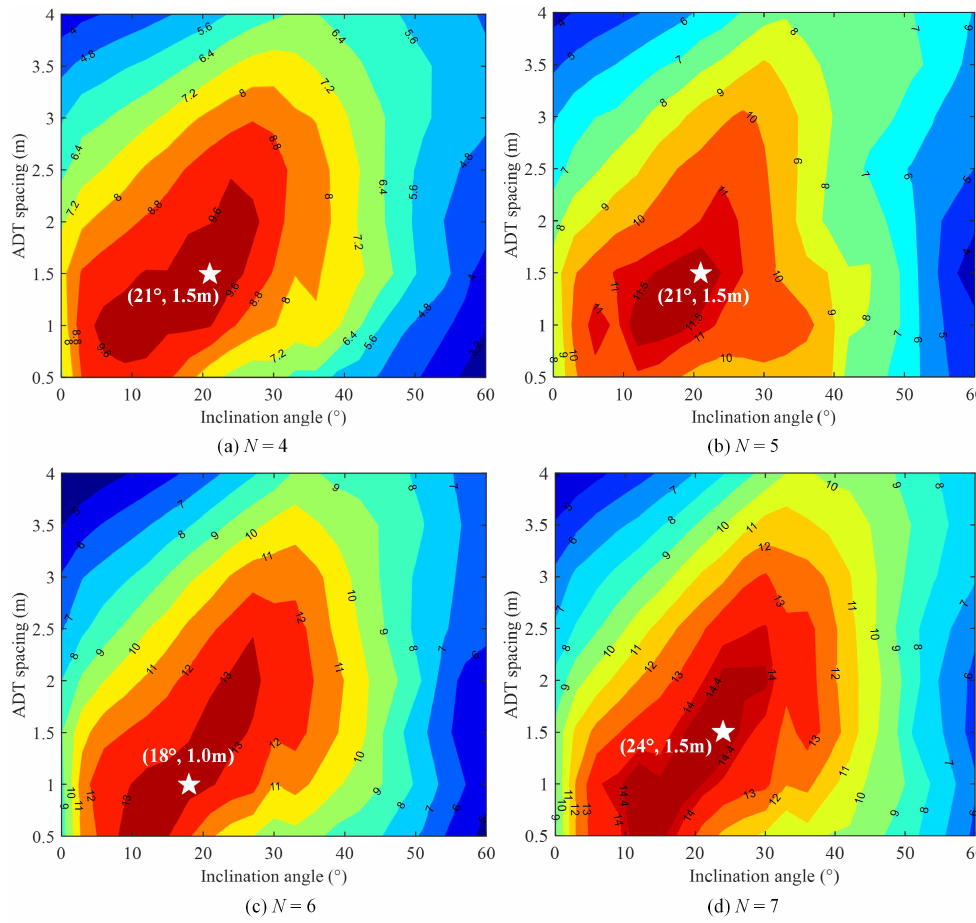
Figure 5. Contour plot of the average achievable rate (bit/s/Hz) vs. inclination angle θ and ADT spacing 2 d for ( a ) N = 4, ( b ) N = 5, ( c ) N = 6 and ( d ) N =